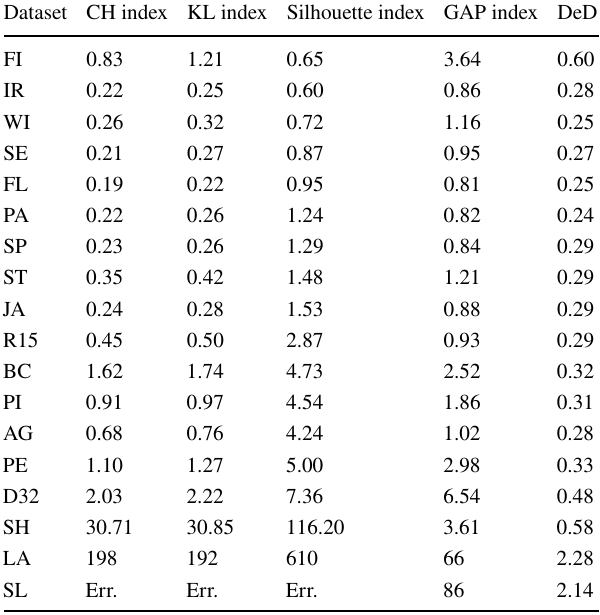
Table 8 Average runtime (s) of 10